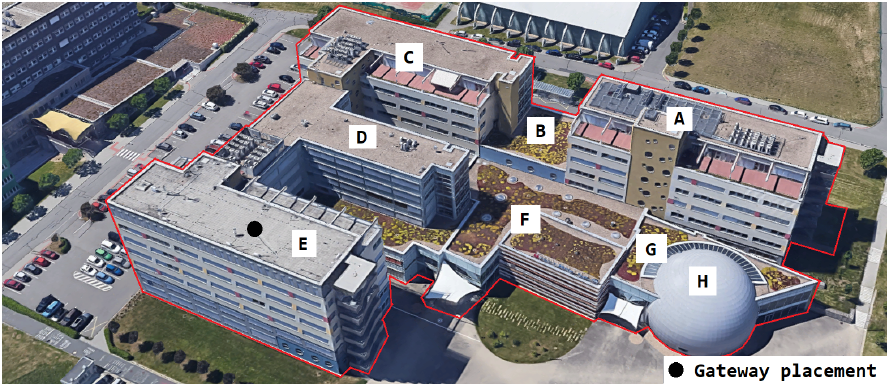
Figure 3. Location of our private one-gateway LoRaWAN experimental network with view of the individual buildings of the Electrical faculty (A–H are the names of the buildings).